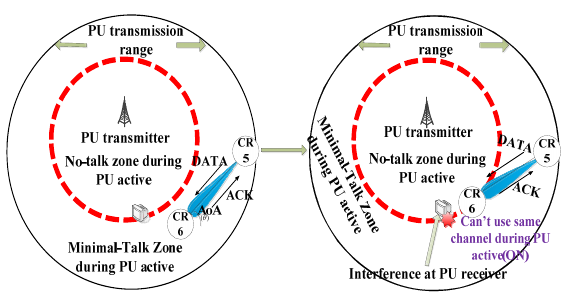
Figure 2. PU receiver interference due to CR node mobility.